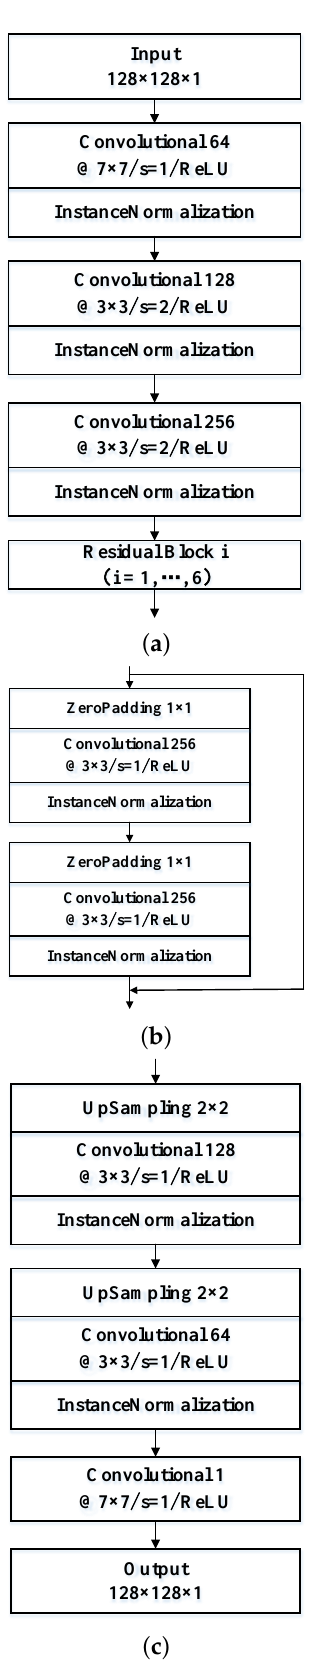
Figure 3. Architecture of the image reconstruction model. ( a ) Feature extraction module. ( b ) Details of the residual block. ( c ) Feature restoration